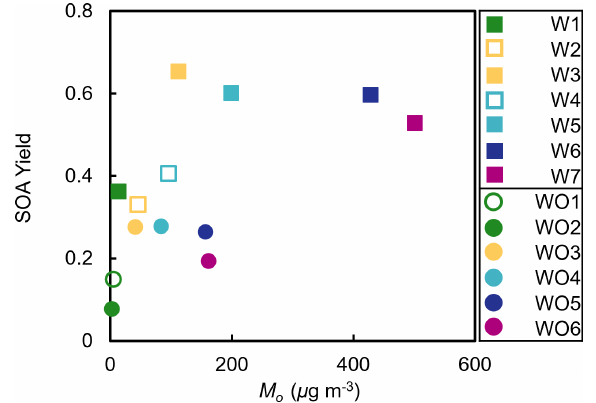
Figure 3. Measured camphene SOA mass yields as a function of SOA mass ( M o ). Squares indicate experiments with (W) and circles without (WO) added NO x . Initial HC mixing ratios are differenti- ated by color; open symbols are used to indicate replicate initial HC mixing ratios.